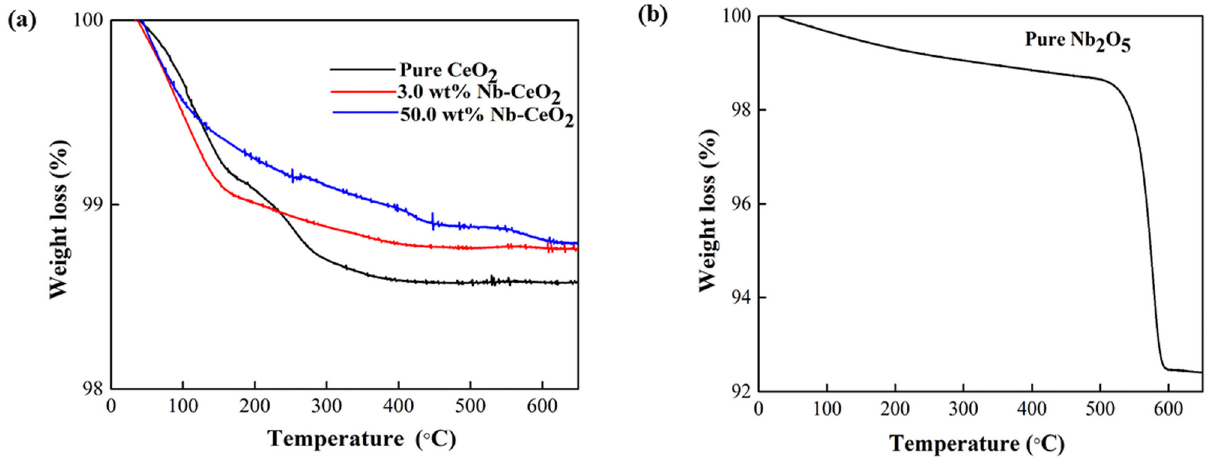
Figure 6: TGA results of the prepared samples ( a ) CeO 2 , 3 wt% doped, and 50 wt% doped Nb - CeO 2 and ( b ) Nb 2 O 5